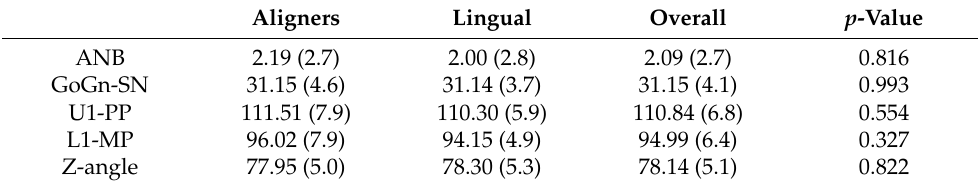
Table 2. Cephalometric measurements by group (mean, SD).